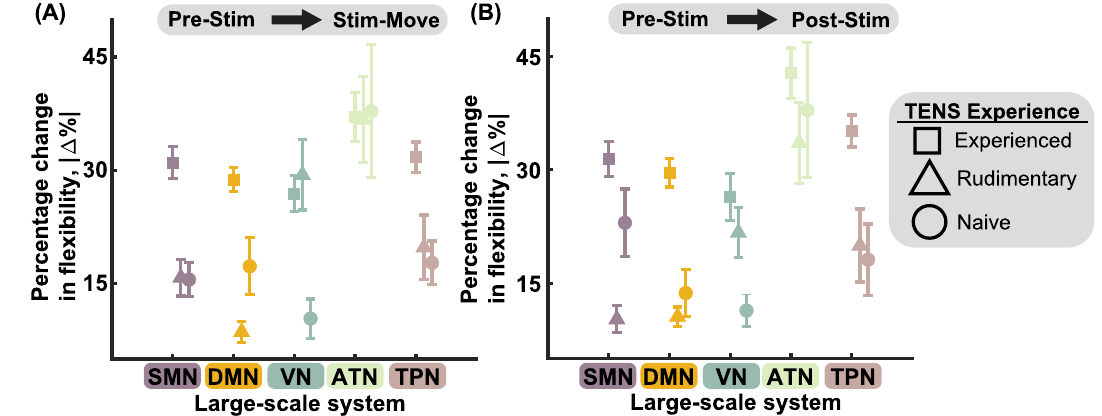
Figure 3. Percentage change in system-level flexibility for each level of tTENS experience. ( A ) Comparing Pre-Stim with Stim-Move, the percentage changes in flexibility of SMN, DMN, ATN, and TPN were the greatest for the participant with ample tTENS experience (A01). For all large-scale systems, the percentage change in flexibility was greater for the participant with rudimentary tTENS experience (A02) than that for the participant with no tTENS experience (A03). ( B ) Comparing Pre-Stim with Post-Stim, the percentage change in flexibility was the greatest in A01. For SMN, VN, and TPN, the percentage change was greater for A02 then for A03.